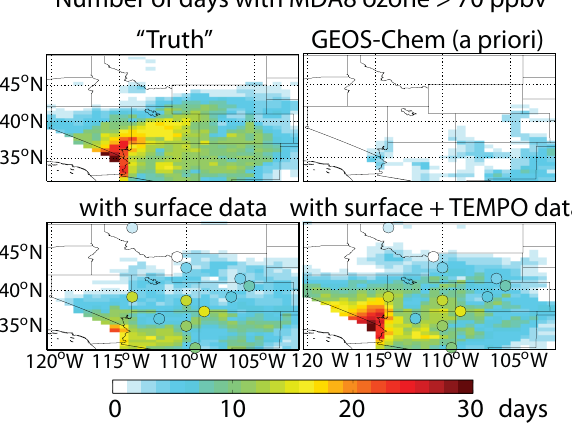
Figure 5. Improved detection of high-ozone events in the Inter- mountain West by data assimilation. The figure shows the number of events (daily maximum 8h ozone > 70ppbv) in April–June 2010 on the GEOS-Chem grid. The “truth” defined by the GFDL AM3 model (top left panel) is compared to GEOS-Chem simulations without data assimilation (top right), with assimilation of synthetic CASTNet surface data (bottom left), and with additional assimi- lation of synthetic TEMPO and LEO satellite data (bottom right). Locations of CASTNet surface sites used for assimilation with their “true” values are overlain in the bottom